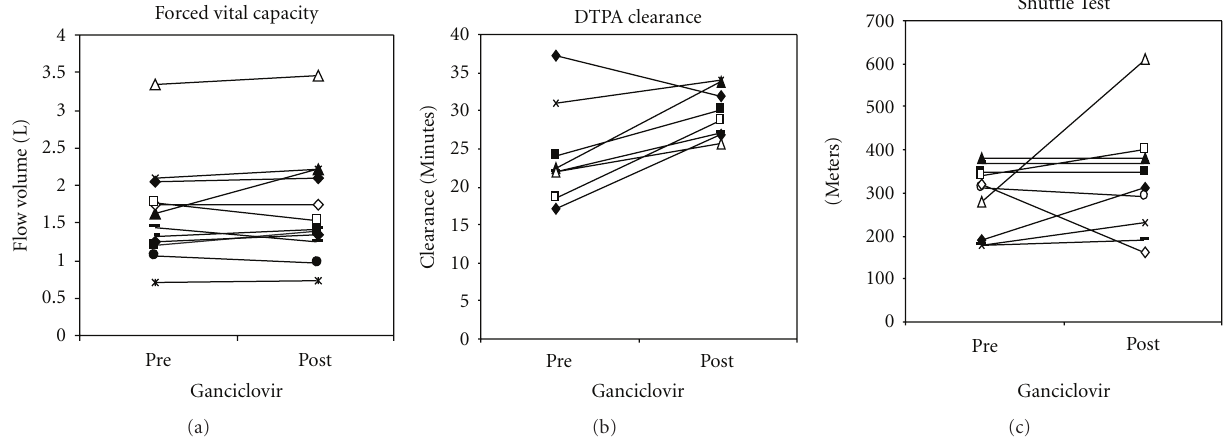
Figure 1: Patient characteristics following Ganciclovir. ∗ Some patients were unable to perform the test due to breathlessness.